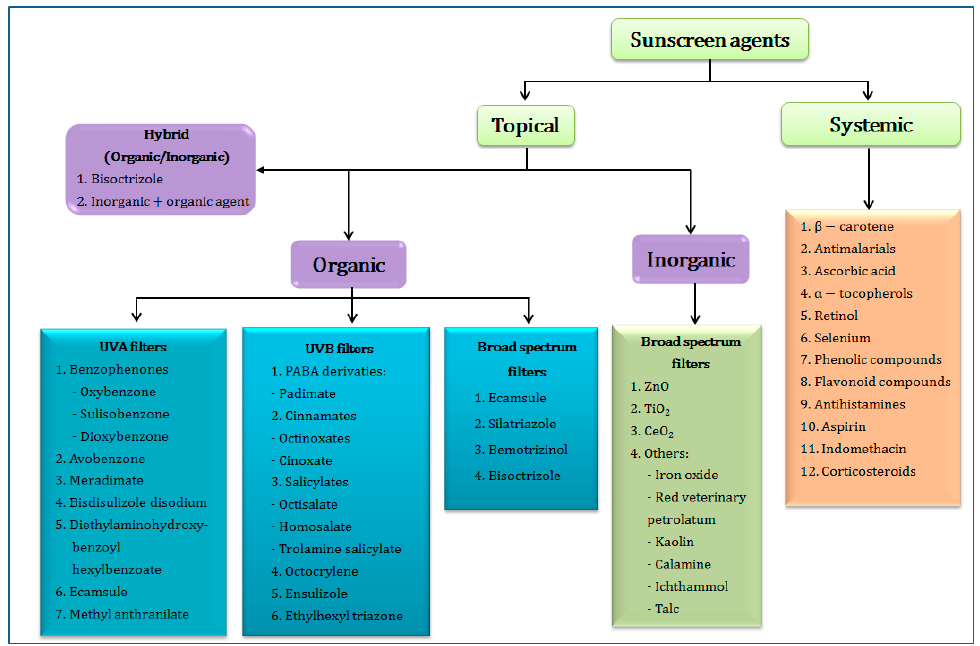
Figure 3. Sunscreen agent classification [23].